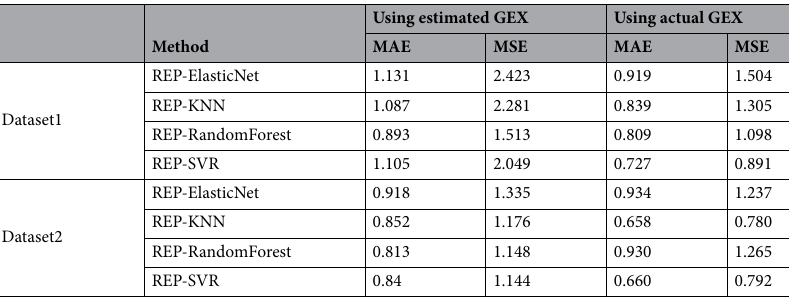
Table 5. Regression performance comparison using estimated and actual GEX values on Dataset1 and Dataset2. Columns corresponding to “estimated GEX” represent analysis in which in the test set, only the GEX values at the initial time point were used and the GEX of later time points were estimated. Columns corresponding to “actual GEX” represent analysis in which in the test set, GEX values of all time points were